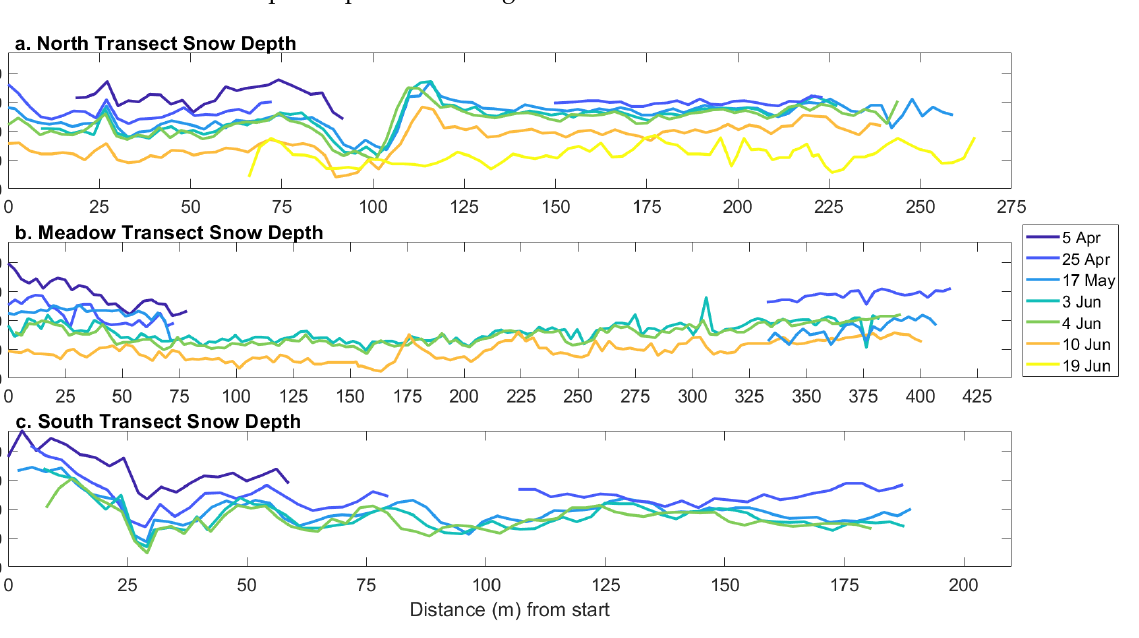
Figure 8. Probed snow depth measurements on the ( a ) North, ( b ) Meadow, and ( c ) South Transects. Snow depths on 5 April ( a – c ), 25 April ( a – c ), and 17 May ( b ) surveys were acquired on a subset of the transect. Transect terminus varied by up to 5 m in length throughout the survey period.